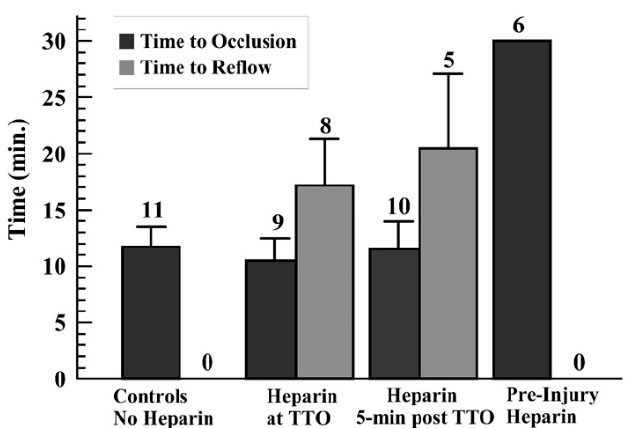
nonsurvival is defined as occlusion, marked as the TTO; these data are shown for the groups in Supplemental Figure S5.